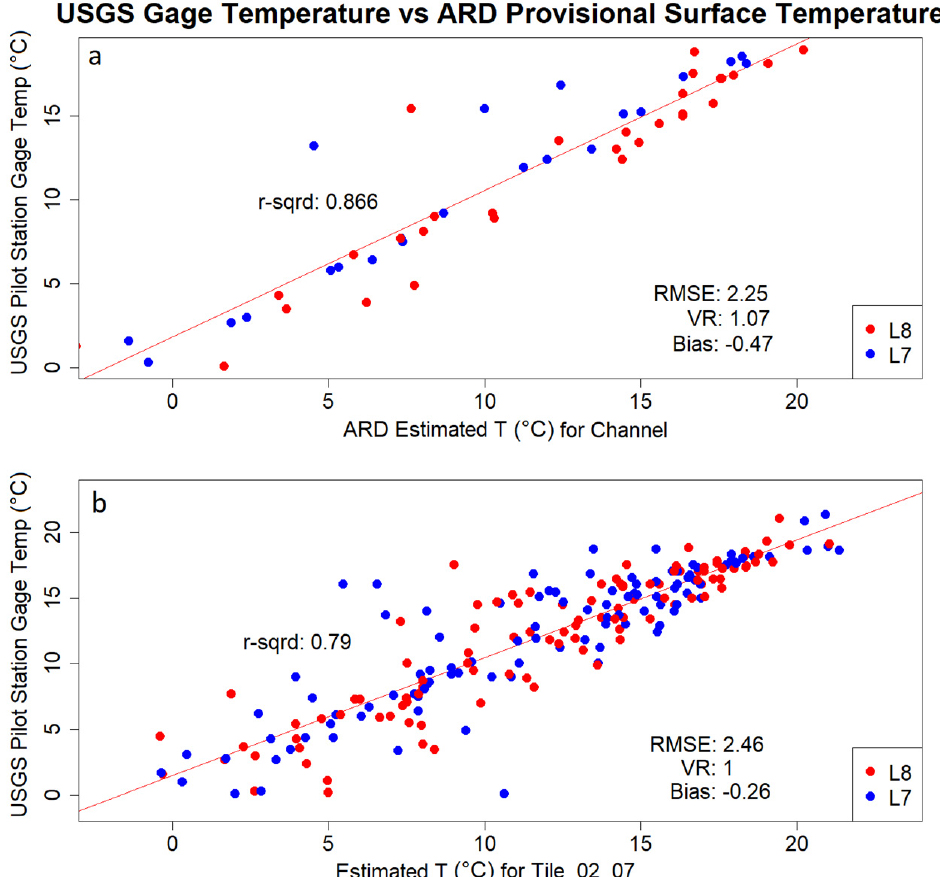
Figure 4. Agreement between USGS streamgage measurements and ARD estimates averaged over the ( a ) Channel AOI and ( b ) the portion of the Yukon River captured by ARD tile AK-0207.